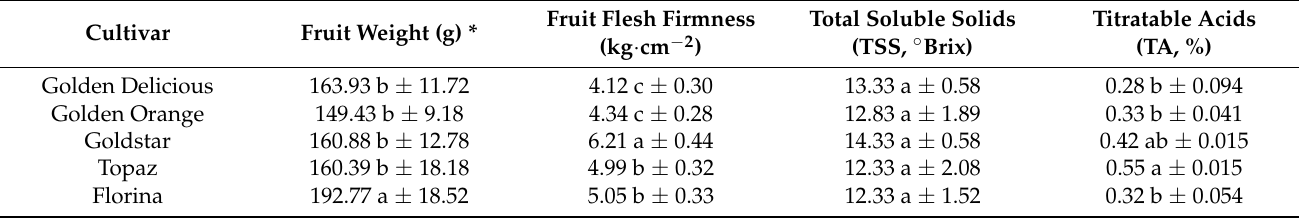
Table 1. Average value of measured fruit weight, flesh firmness content and total soluble solids of the tested apple cultivars (mean ± standard deviation).